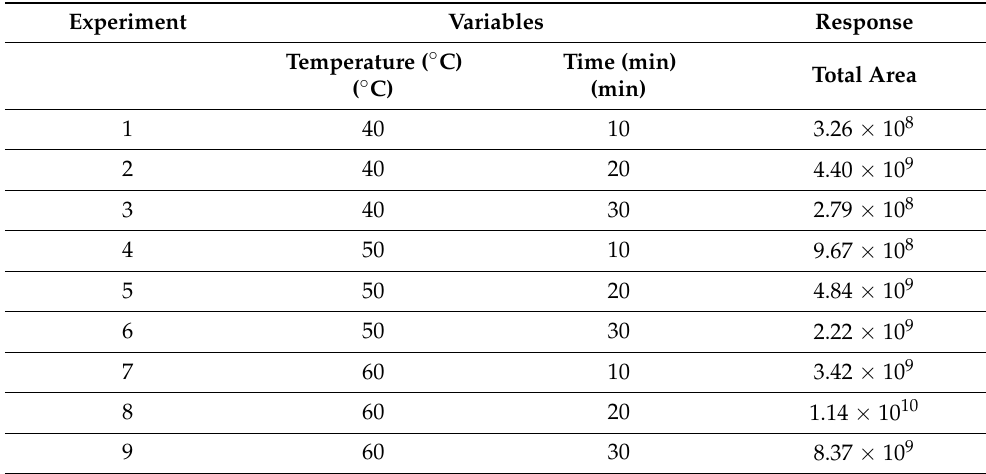
Table 2. Values of the response obtained at the variation levels chosen for the variables selected for HS-SPME optimization by experimental design, i.e., extraction temperature and extraction